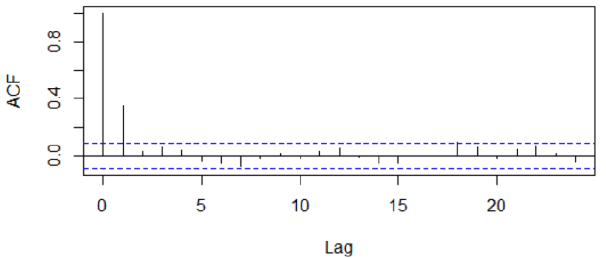
Figure 5: CF plot of